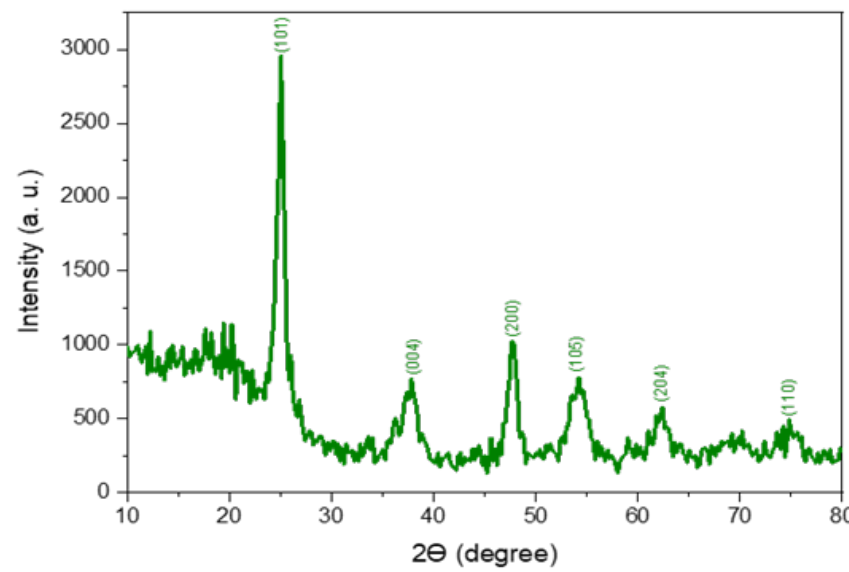
Figure 8. X-ray pattern of TiO 2 nanorods after heat treatment.